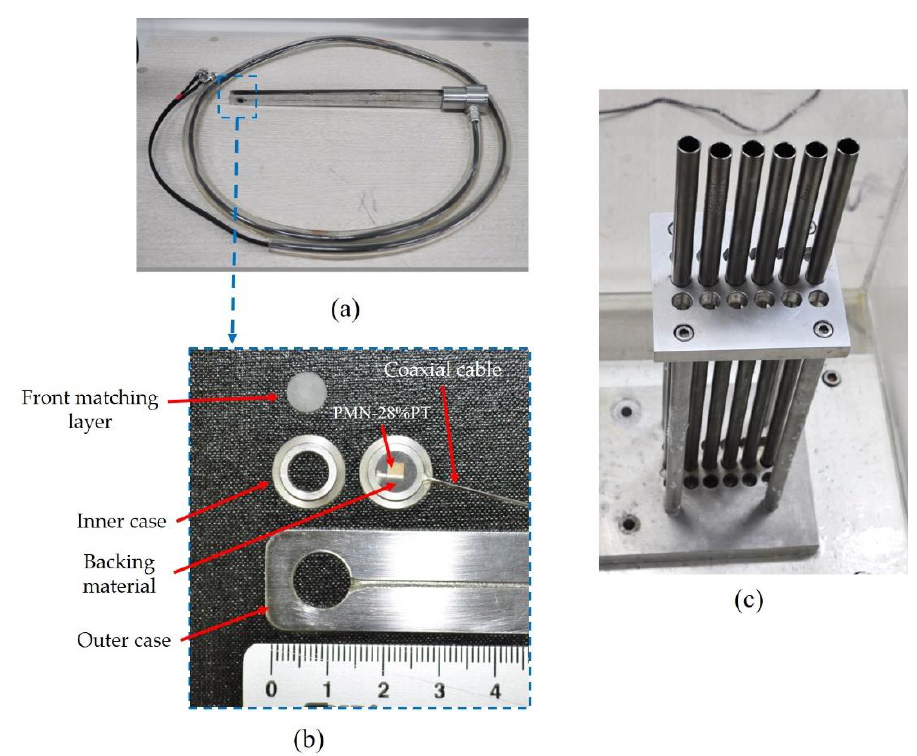
Figure 8. Newly developed PMN-28%PT-based ultrasonic transducer for NDE of PWR fuel rods: ( a ) Prototype ultrasonic transducer; ( b ) magnified image of ultrasonic transducer and its components; ( c ) PWR fuel rod assembly samples.